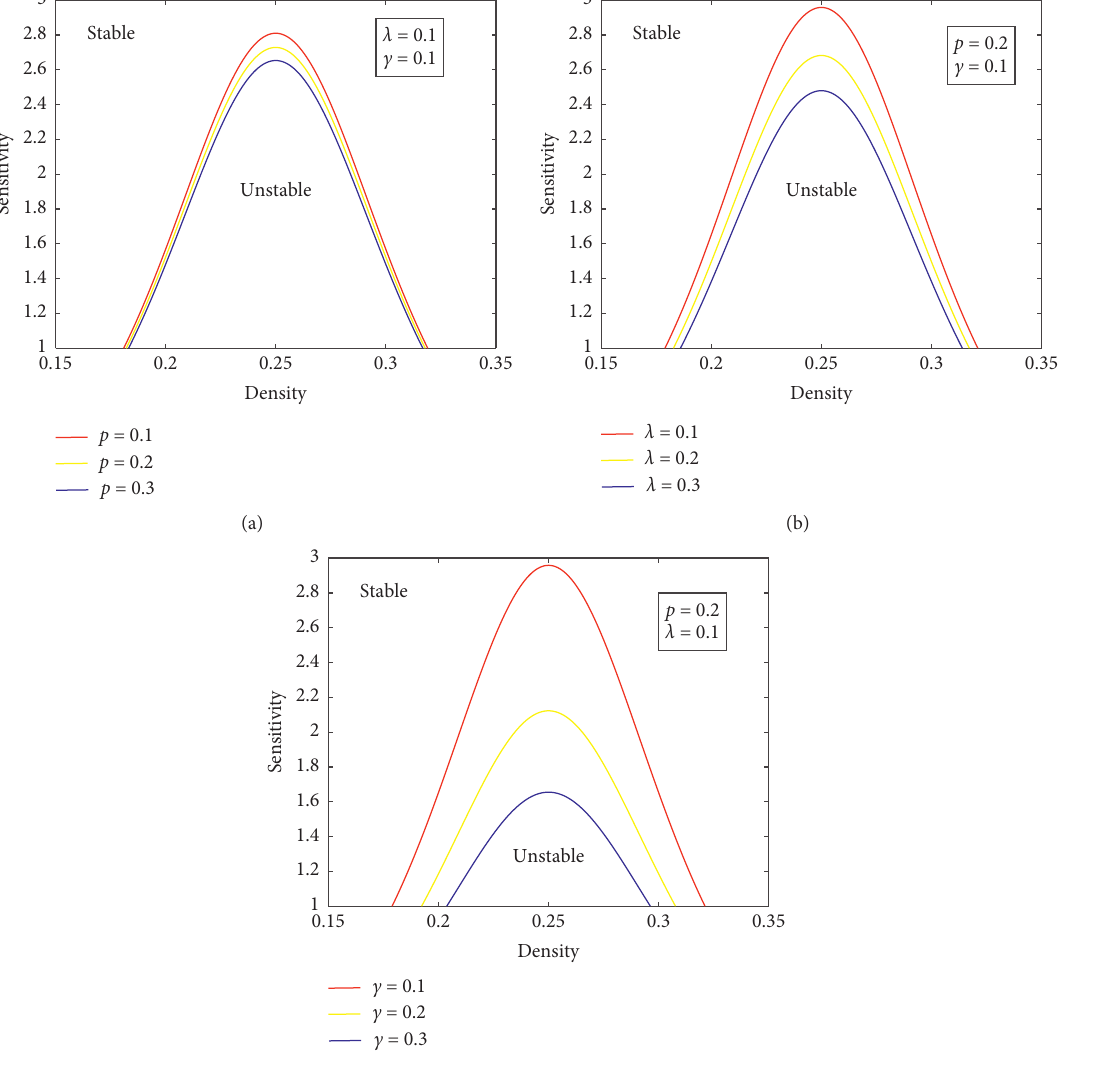
Table 1: The coefficients k Symbol